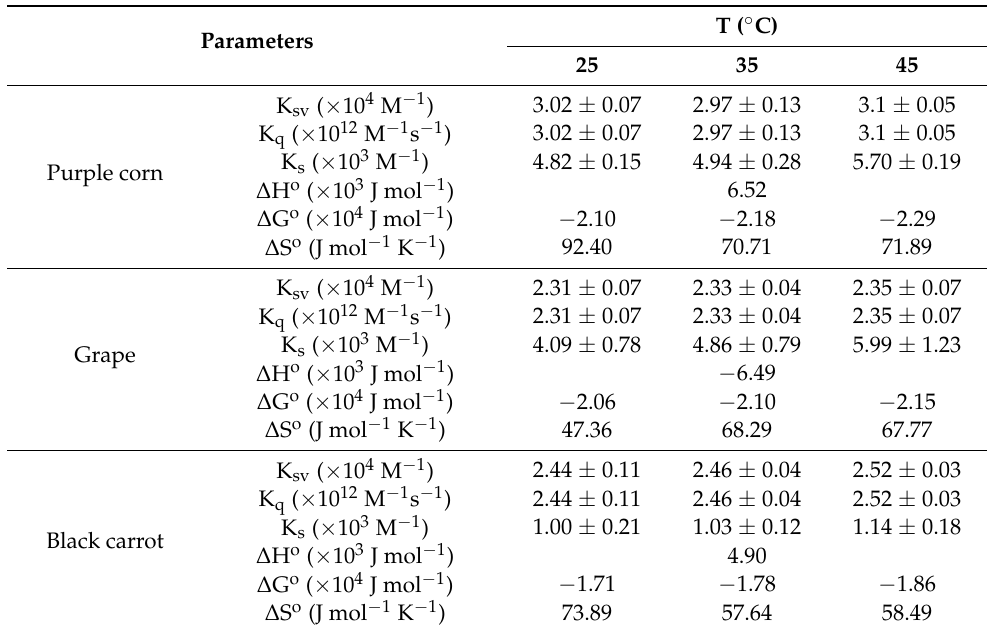
Table 1. The K s for all three ACN–WP solutions were in the order of 10 3 , indicating